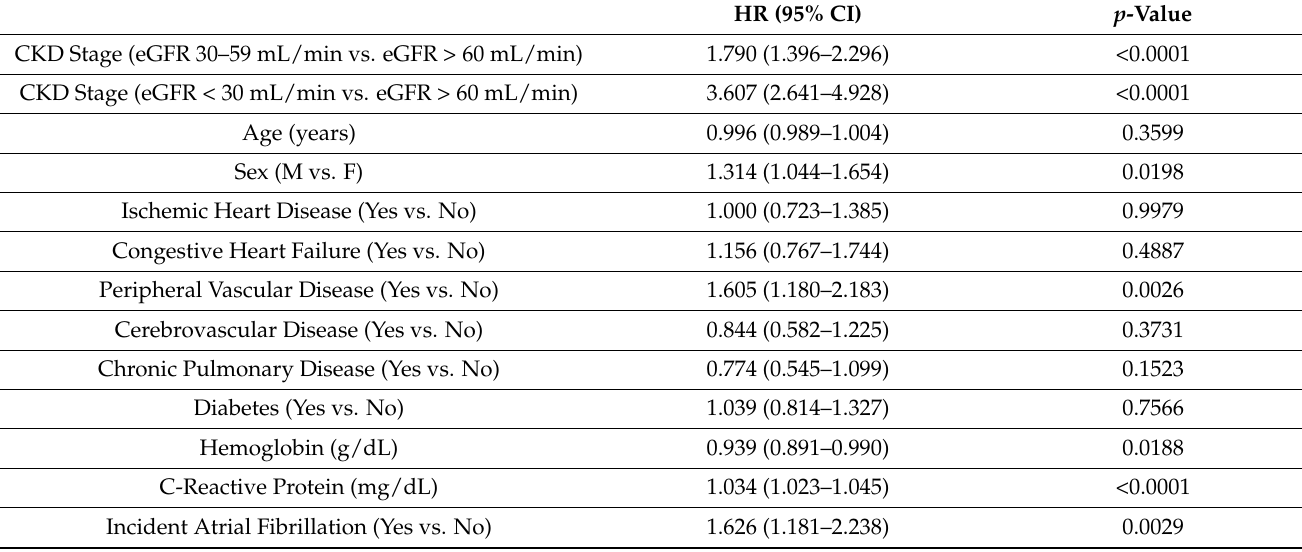
Table A6. Cause-specific hazard regression model for